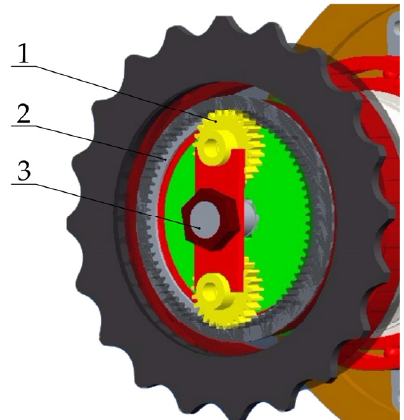
Figure 7. Differential wheel mechanism 3D model. 1. Planetary wheel; 2. Inner gear ring; 3. Sprocket shaft.